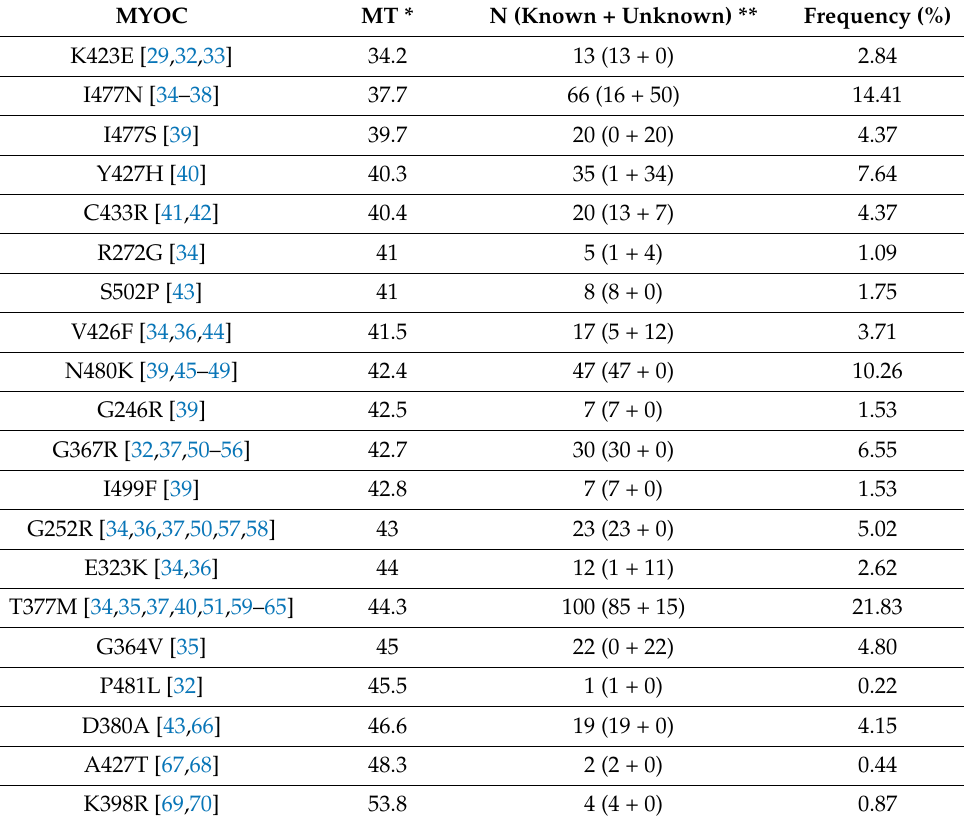
Table 1. Number of Patients (known and unknown individual age).